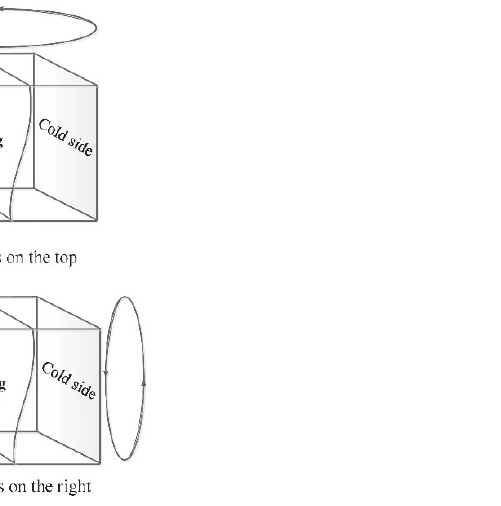
Figure 32. The physical system investigated in [112]. Reproduced with permission from Elsevier.